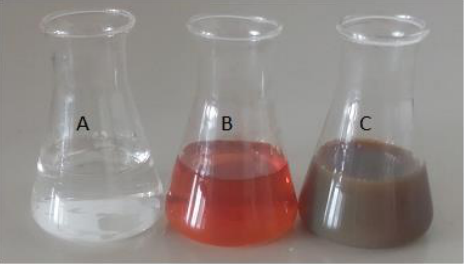
Figure 1. ( A ): Colorless solution of AgNO 3 ( B ): After the addition of bark extract, orange color appeared ( C ): Orange color changed to dark grey, indicating the AgNPs formation. The color change indicated the formation of AgNPs that was certified by UV–Visible absorption. For UV–Visible analysis, a small fraction of solution diluted with 5 mL distilled water was taken into a cuvette, whereas blank reading was taken by using distilled water as a reference. The wavelength range of the spectrophotometer was selected in the region of 300–800 nm for each sample. Bark extract of A. indica was used to reduce the silver and stabilize the resulting AgNO 3 . The UV–Visible spectroscopy showed active absorption at 461 nm because of Surface Plasmon Resonance in AgNPs after 15 min of exposure. With passing time, the peak was shifted towards the higher wavelength (467 nm), which is attributed to the increased size of AgNPs as time elapsed. Similarly, after 2 h the absorption band further enhanced, which showed more formation of AgNPs. Finally, after 24 h, the peak was observed at about 471 nm, which showed maximum reduction and completion of the AgNPs formation (Figure 2).